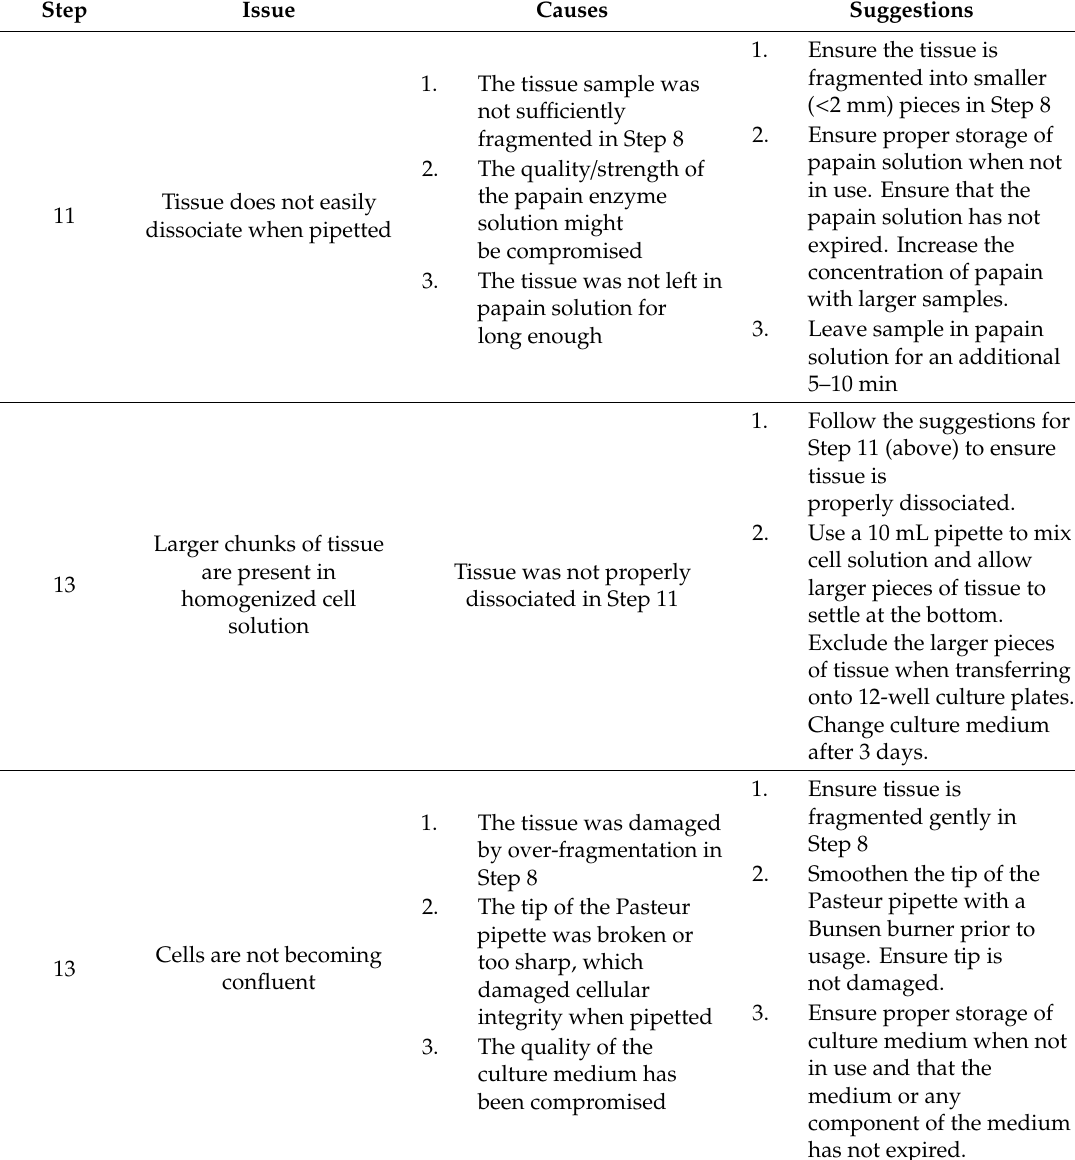
Table 1. Potential issues arising and respective